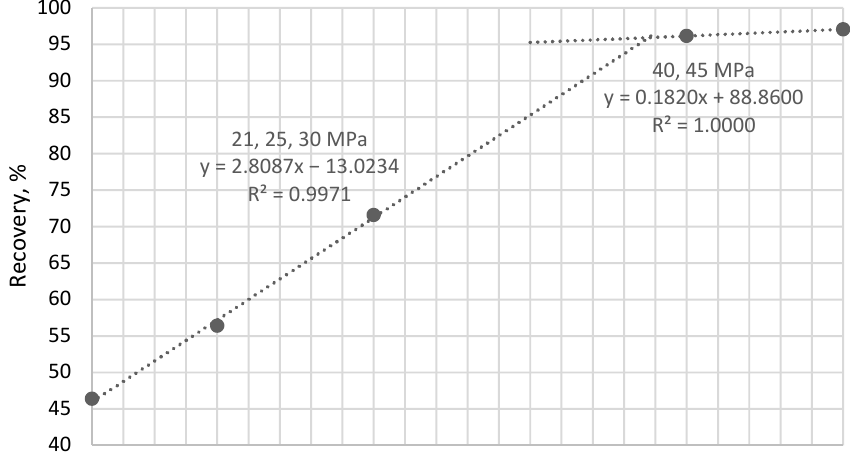
Figure 4. Results of linear intersection to determine the MMP. Table 1. Results of MMP calculation using statistical regression methods.